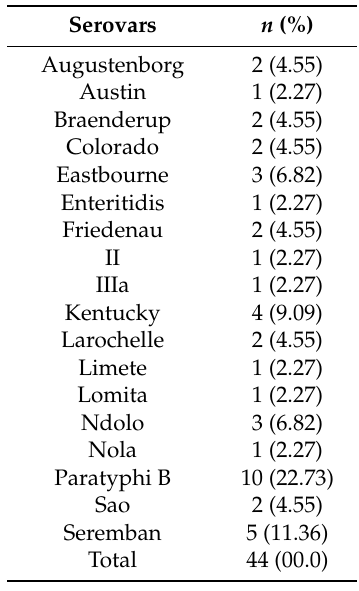
Table 2. Salmonella serovars of pooled cultivated oysters ( n = 44) of Phang Nga Bay in southern Thailand, March 2016 to February 2017.